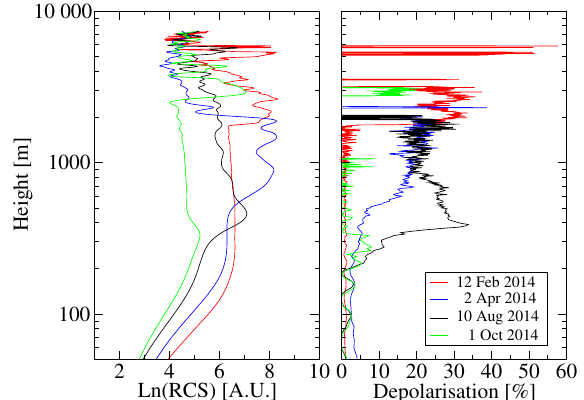
Figure 7. Logarithmic RCS and depolarisation signal correspond- ing to the 4 selected days in coincidence with the measurements nearest to